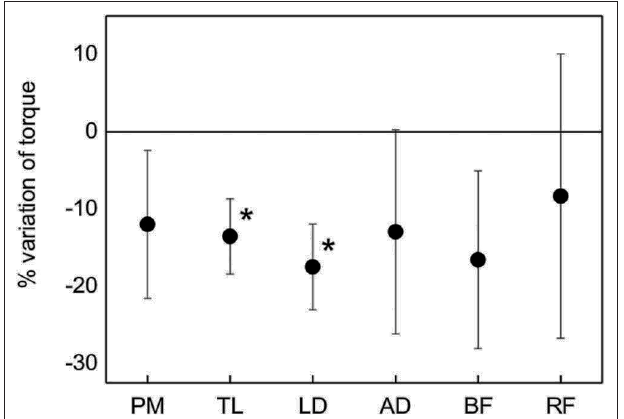
FIGURE 5 | Average percent variation of the torque for each muscle from the pre-MICT to the post-MICT, representing mechanical fatigue. Asterisks indicate statistical significance ( p < 0.05).